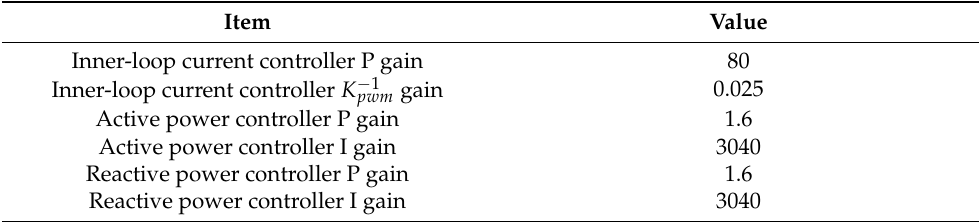
Table 3. Controller parameters of proposed MG inverter controllers.